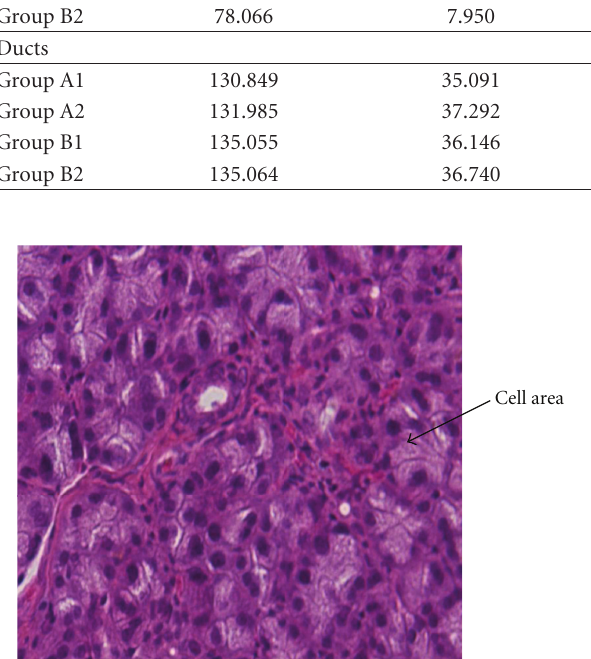
Figure 2: In group B2, there were not significant alterations in the cell area or the number and the diameter of the ducts of the parotid gland (haematoxylin eosin—original magnification ×